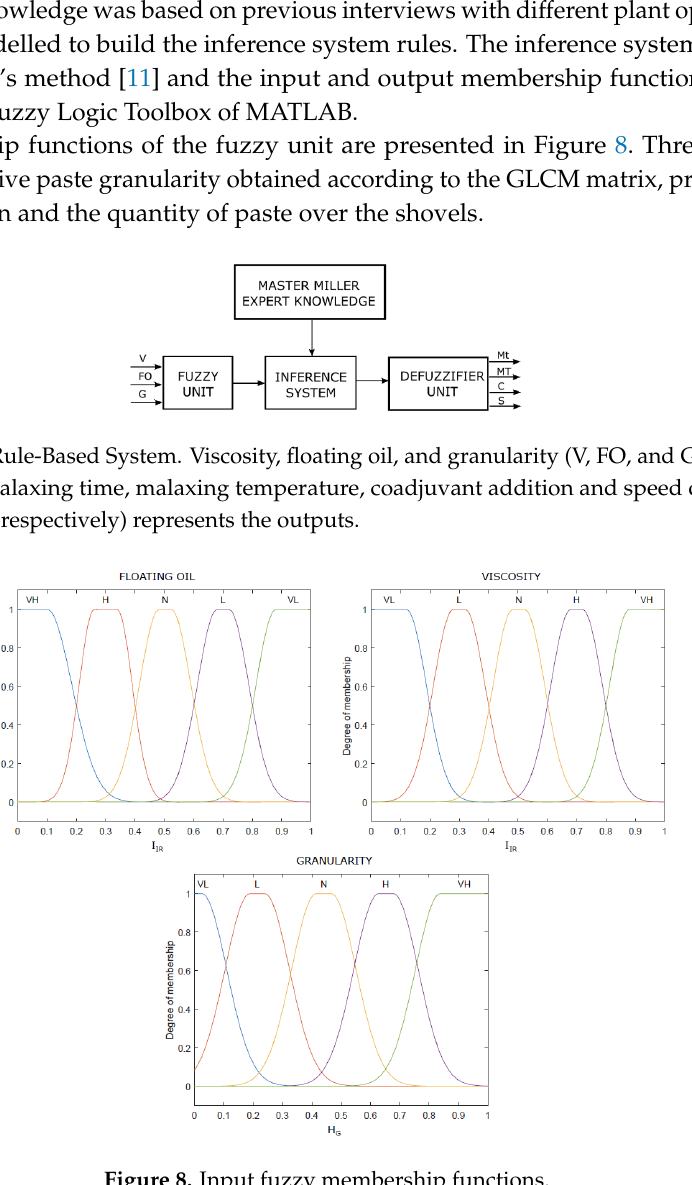
Figure 8. Input fuzzy membership functions.